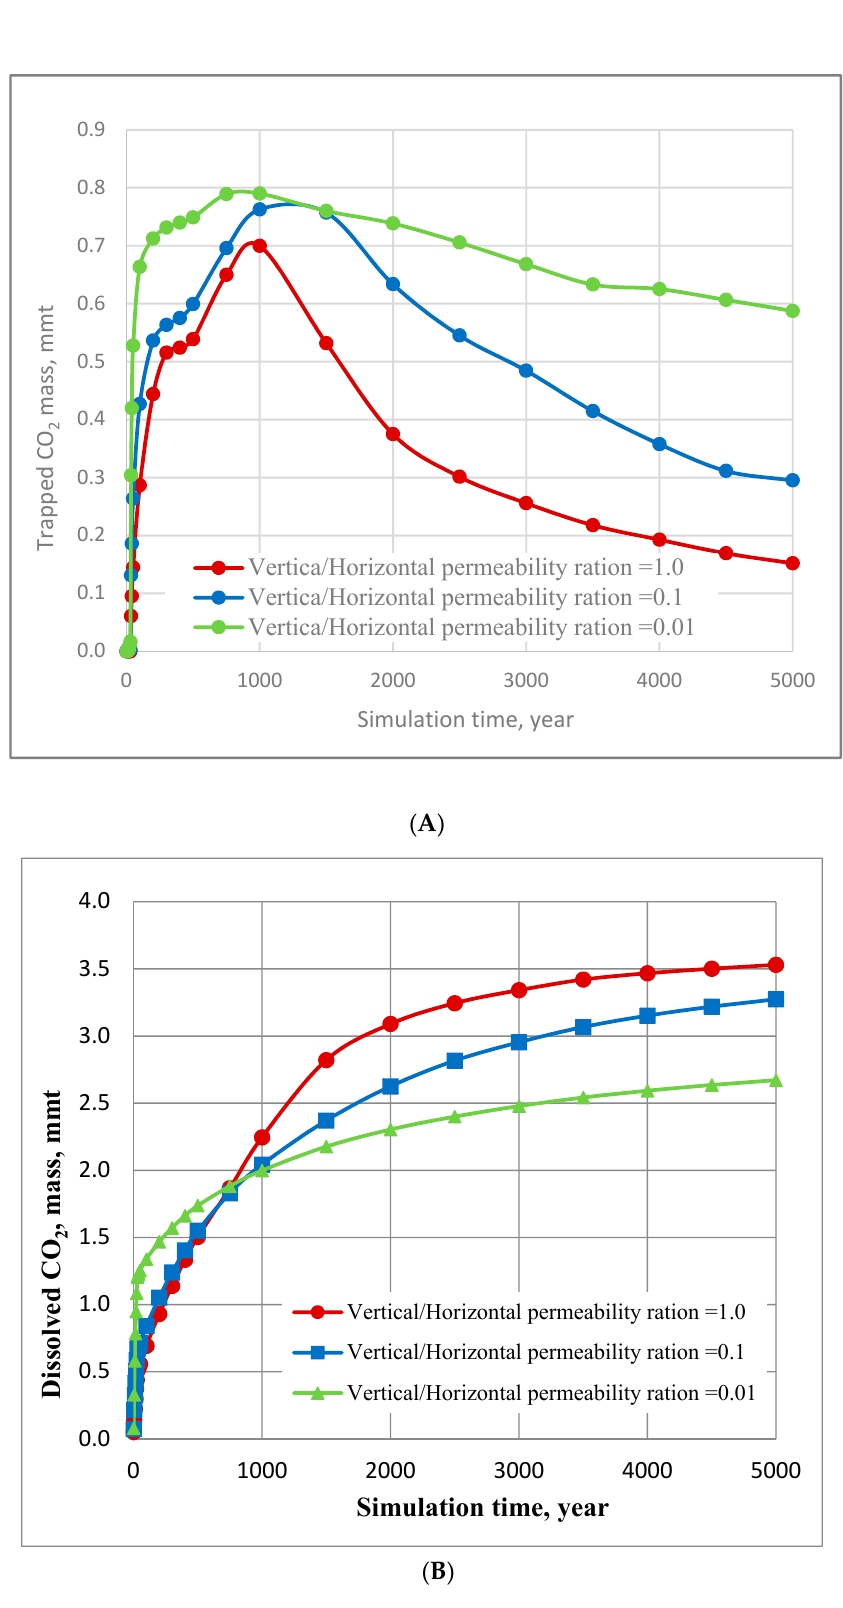
Figure 10. The impact of the vertical/horizontal permeability ratio on CO 2 distribution after 500 years in a homogeneous domain. Cases 8, 9 and 10 in Table 3.